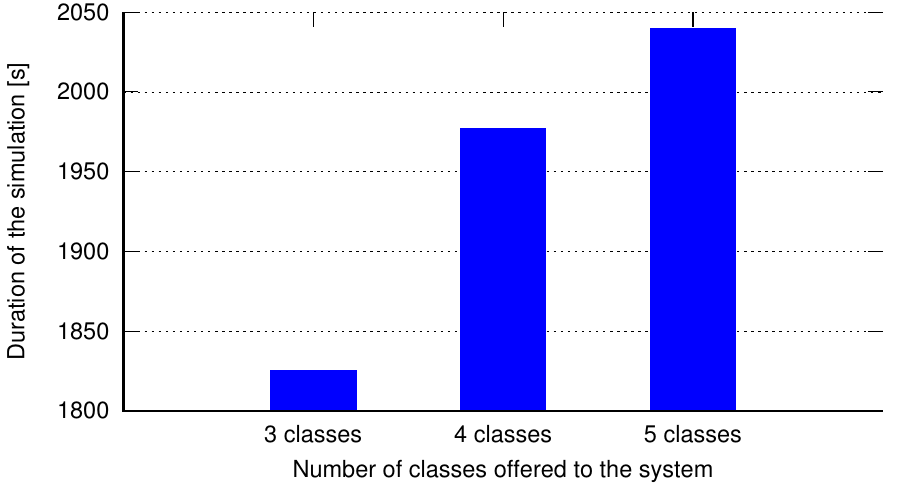
Figure 19. Duration of simulation in relation to the number of classes offered to the system.